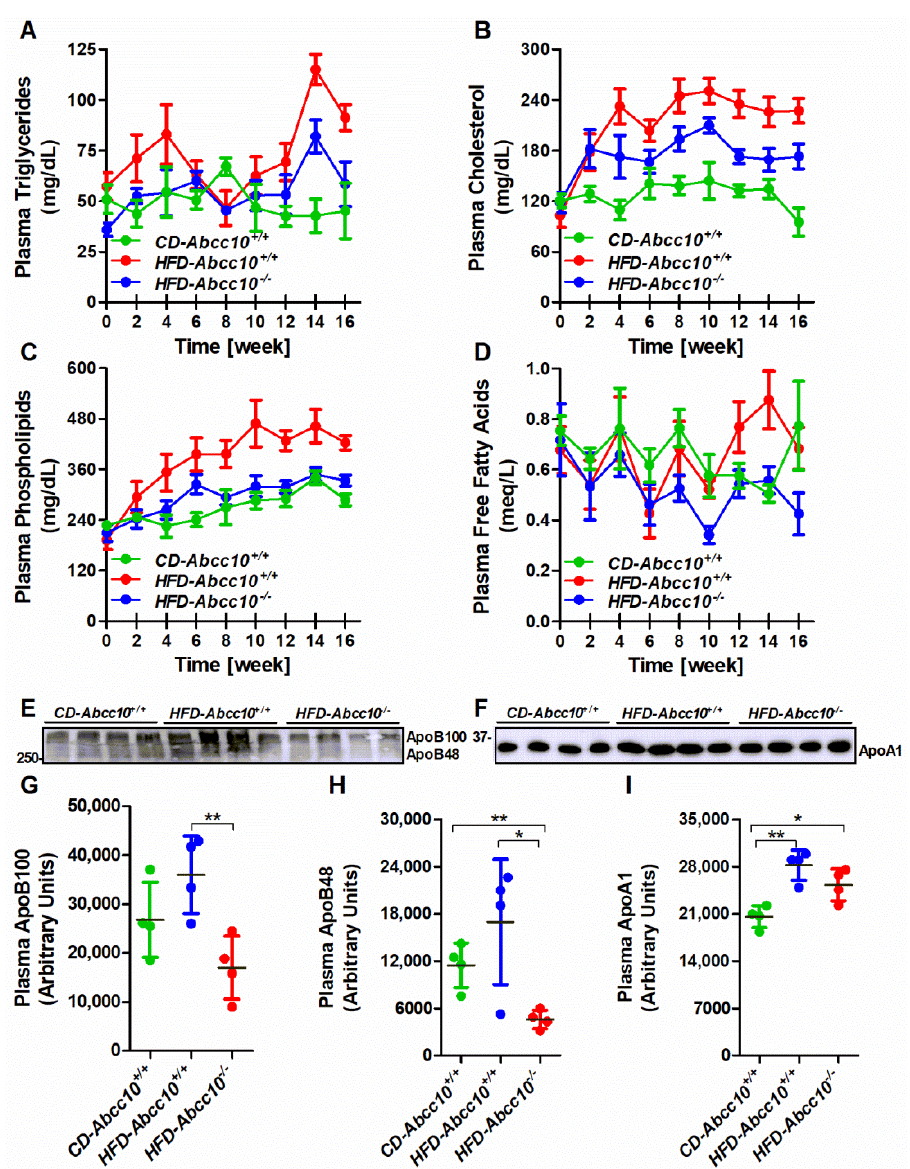
Figure 3. Deficiency of ABCC10 reduces plasma lipids and apoB lipoproteins in high-fat-diet-fed mice. Eight-week-old Abcc10 +/+ ( HFD-Abcc10 +/+ , n = 4) and Abcc10 − / − ( HFD-Abcc10 − / − , n = 5) male mice were fed high-fat obesity diet for 16 weeks. As a control, age-matched Abcc10 +/+ ( CD-Abcc10 +/+ , n = 4) male mice were kept on chow diet during this period. Blood was collected every two weeks in the overnight-fasted mice and plasma was isolated to measure total triglycerides ( A ), cholesterol ( B ), phospholipids ( C ), and free fatty acids ( D ). Plasma at the termination of the experiment was also used to measure the levels of apoB ( E ) and apoA1 ( F ) lipoproteins by Western blotting. Density of the protein bands was quantified by using ImageJ software and the values were plotted ( G – I ). Values are plotted as replicates (mean ± SD). * p < 0.05 and ** p < 0.01.